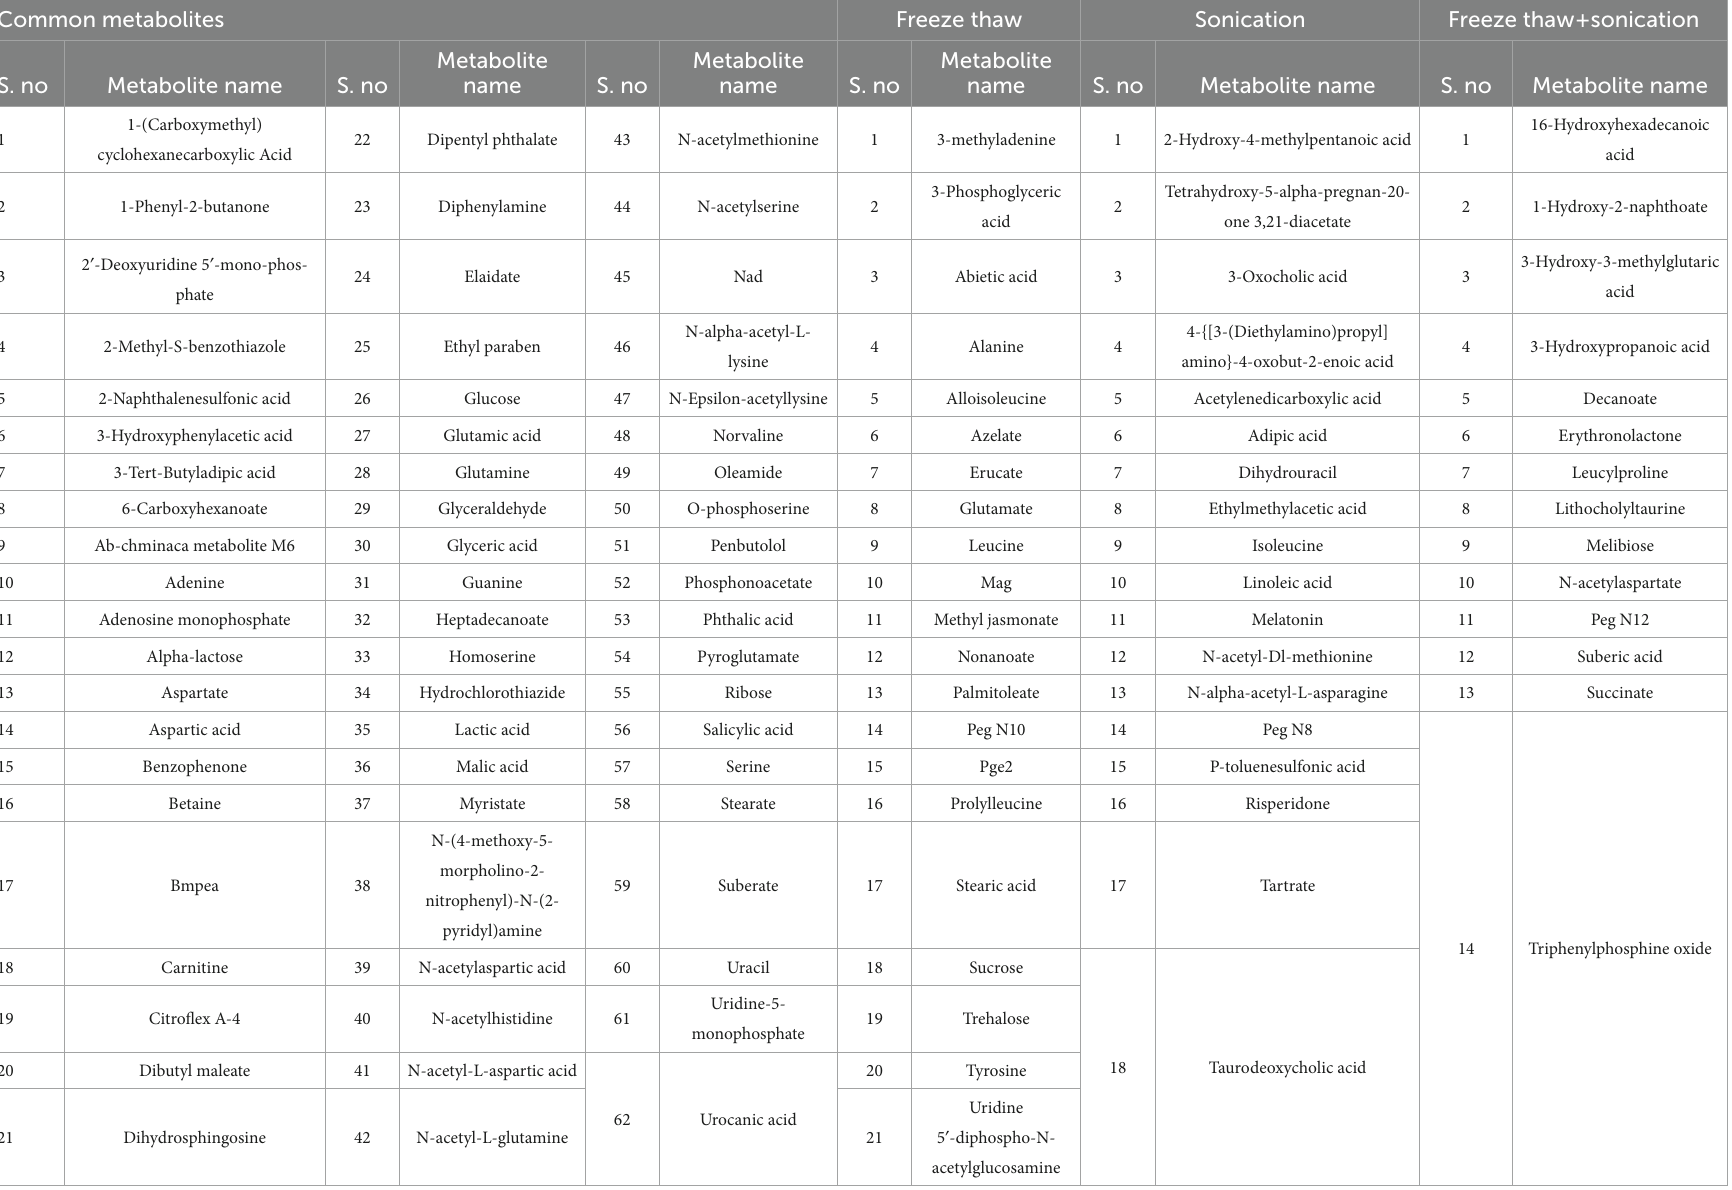
TABLE 2 List of identified metabolites specific to metabolite extraction protocols (FTC, SC, and FTC + SC) as well as commonly identified metabolites among all methods. Common